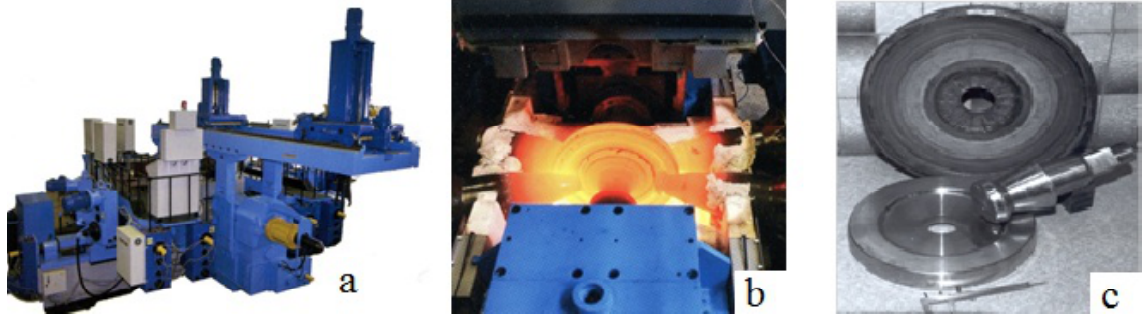
Fig. 5. External view of equipment (a), rolling in the isothermal chamber (b), initial sample. Rolling tool and disk (c), applied for rolling of GTE disks in the conditions of